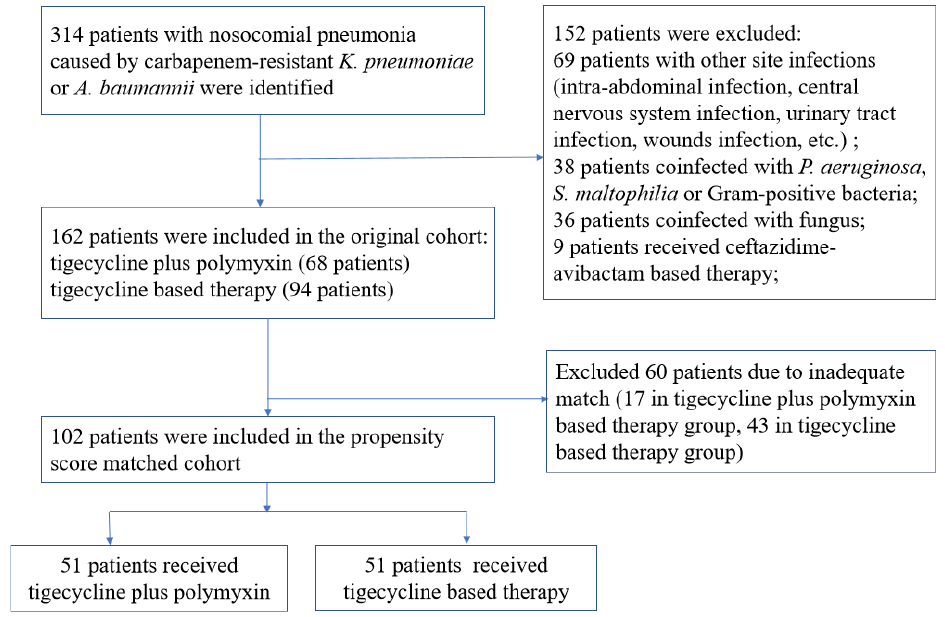
Figure 1. Flowchart of the study inclusion process.